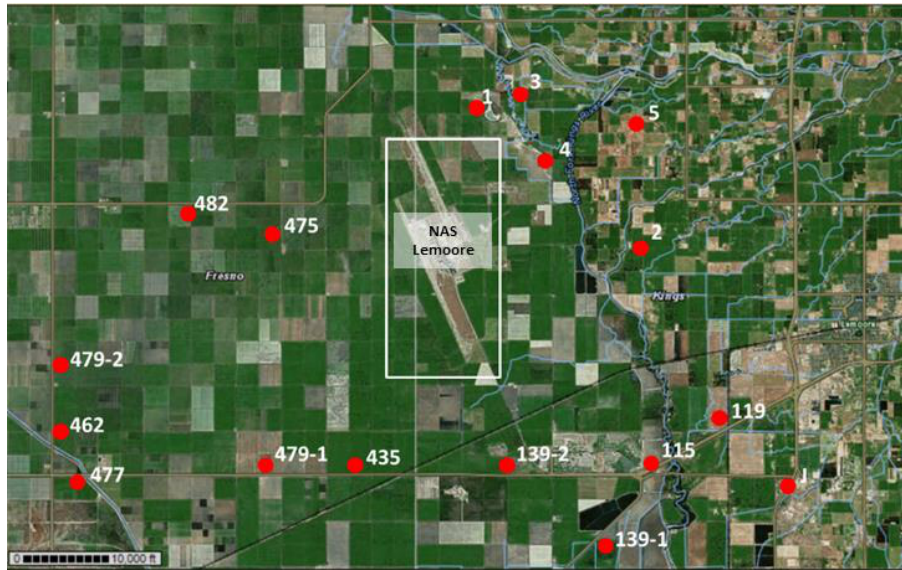
Figure 2. Sampling locations (indicated as red dots) around NAS Lemoore (in the center indicated within white rectangle) in Kings County and Fresno County, CA. Several subsamples were collected at each indicated sampling site (site 151 is off the map, south of site 139-1).